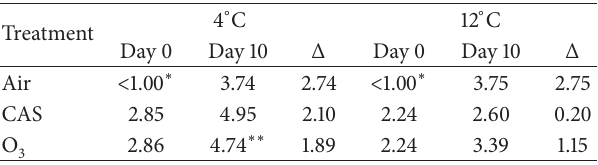
), or regular atmosphere 3